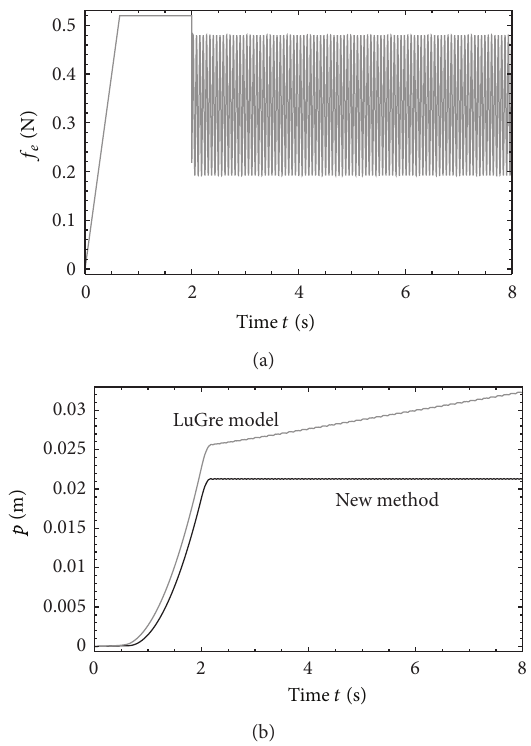
Figure 3: Simulation of the system (10); (a) provided external force 𝑓 𝑒 described as (20); (b) simulation results by RK4 with the timestep size 0.001s. The parameters are chosen as 𝑀 = 1 kg, 𝐹 = 0.5 N, 𝐾 = 5 × 10 3 N/m, and 𝛽 = 2 × 10 −3 s. The initial conditions are 𝑝 = 0 m and ̇𝑝 = 0